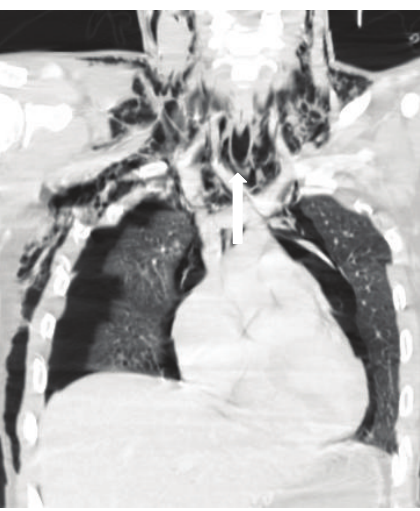
Figure 4: Tracheal rupture. Coronal reconstruction of axial MDCT in lung window. An extensive subcutaneous emphysema, bilat- eral pneumothorax, and pneumomediastinum are observed. Close attention to the tracheal wall depicted a small leak of air to the mediastinum (arrow).